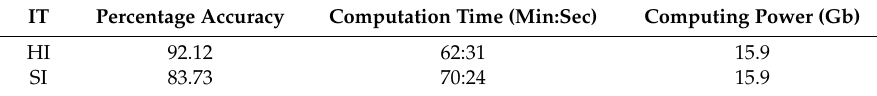
Table 2. Results of CNN on the individual HI and SI from di ff erent heights.